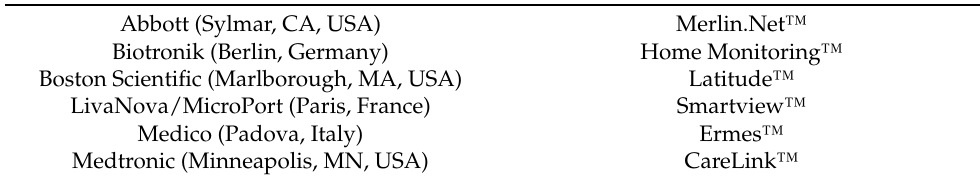
Table 1. Six major CIED companies with their corresponding home monitoring platform. Not all brands are available in every country.